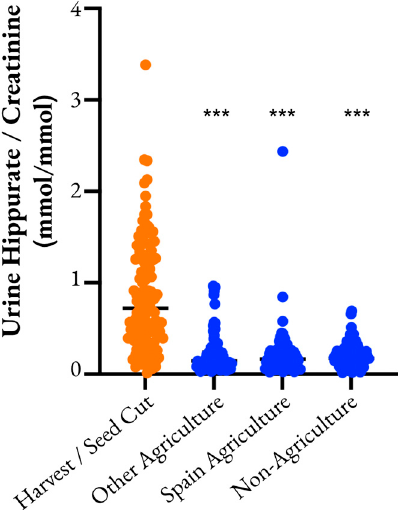
Figure 3. Urinary hippurate across labor-based comparison groups. Groups considered to have a greater risk for subsequent development of Mesoamerican nephropathy are in orange, and those with less risk are in blue. Hippurate is corrected for urinary creatinine level. *** Indicates significant difference from the harvest/seed cutter group at p < 0.0001.